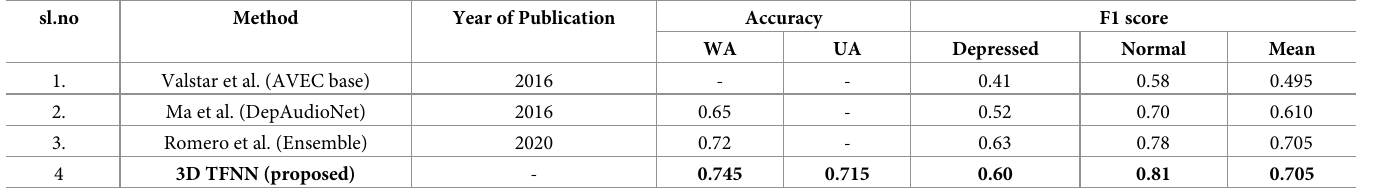
Table 3. Comparison with the state-of-the-art techniques on the test partition of DAIC-WOZ dataset in terms of Weighted Accuracy(WA), Unweighted Accuracy (UA) and F1-scores.